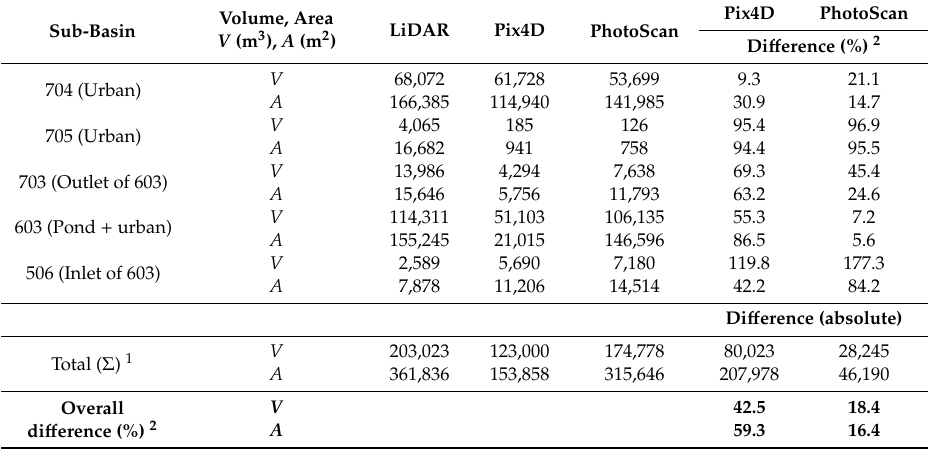
Table 5. Comparisons of the estimations for a local flood event considered by each